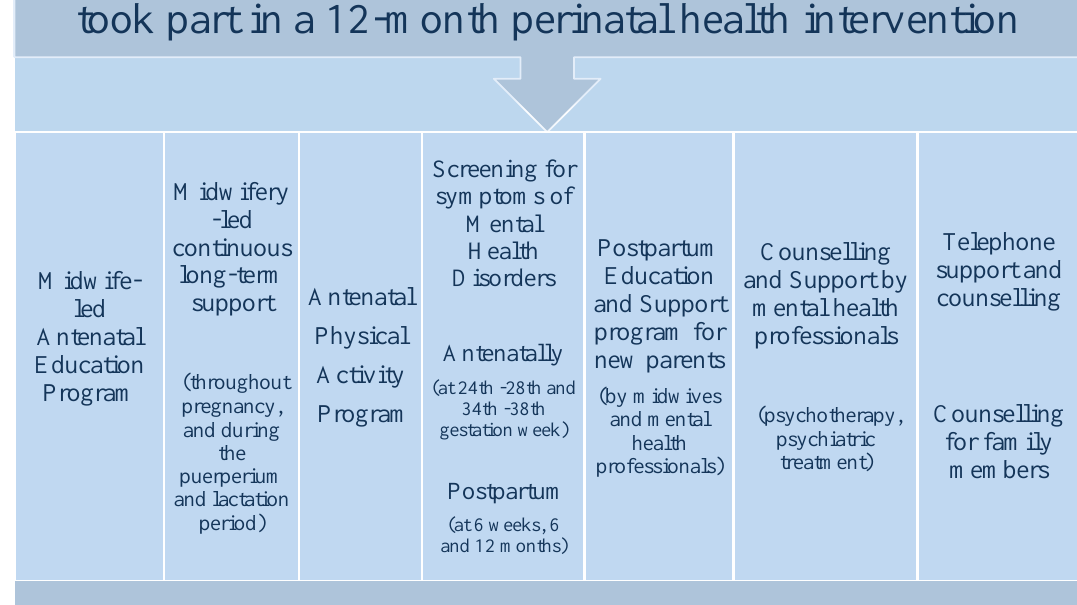
Figure 1. The Perinatal Health Intervention of the Day Center.